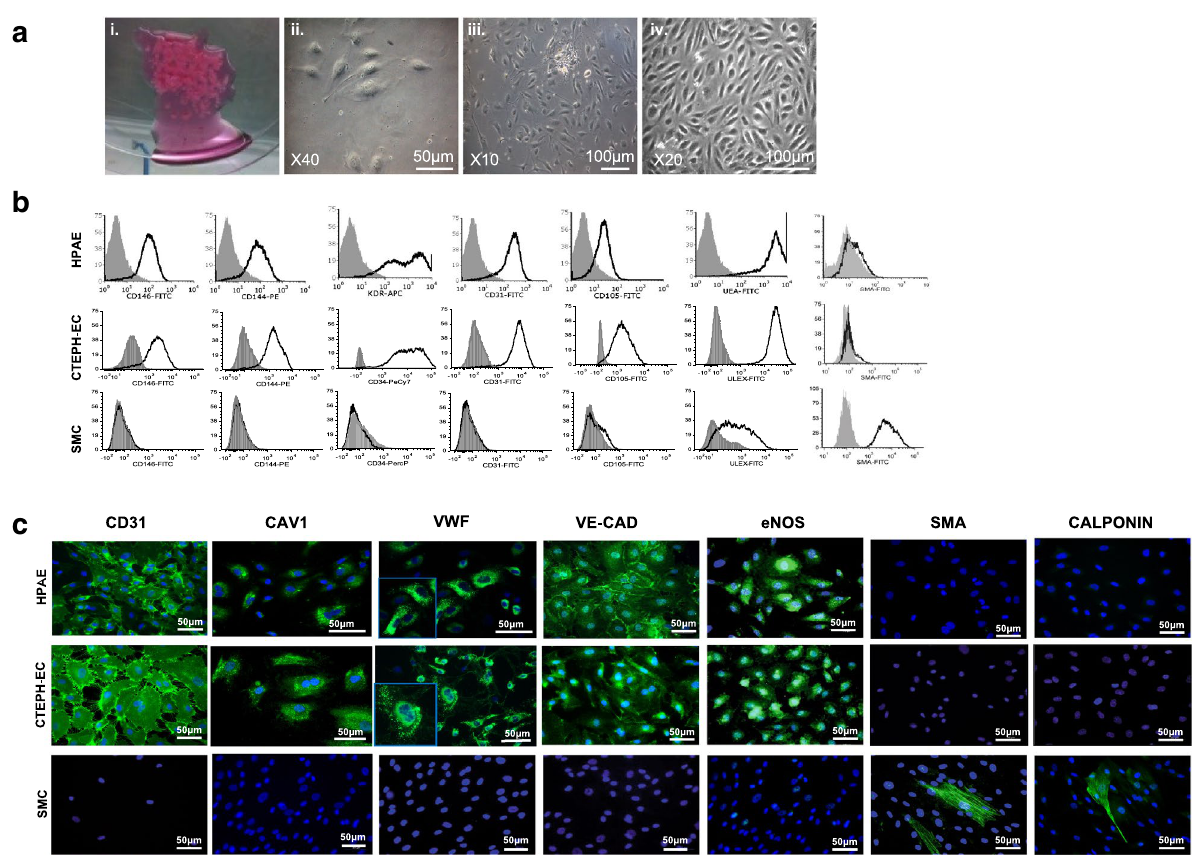
Figure 2. CTEPH-EC characterization. ( a ) Images showing expansion of CTEPH-EC isolated from PEA specimen, (i) minced PEA material, (ii) endothelial colony at day 10, (iii) day 14 and (iv) confluent CTEPH-EC. ( b ) Representative flow cytometry histograms of HPAE, CTEPH-EC and smooth muscle cells (SMC) labelled with antibodies against endothelial surface makers (CD31, UEA-1, vWF, VE-CAD, eNOS) and muscular markers (α-SMA and calponin) (n = 10). ( c ) Representative images of HPAE, CTEPH-EC, and SMC were immune-labelled with antibodies against endothelial makers (CD31, CAV1, vWF, VE-CAD, eNOS) and muscular markers (α-SMA and calponin) (n = 10). Nuclei were counterstained using DAPI (blue) × 40